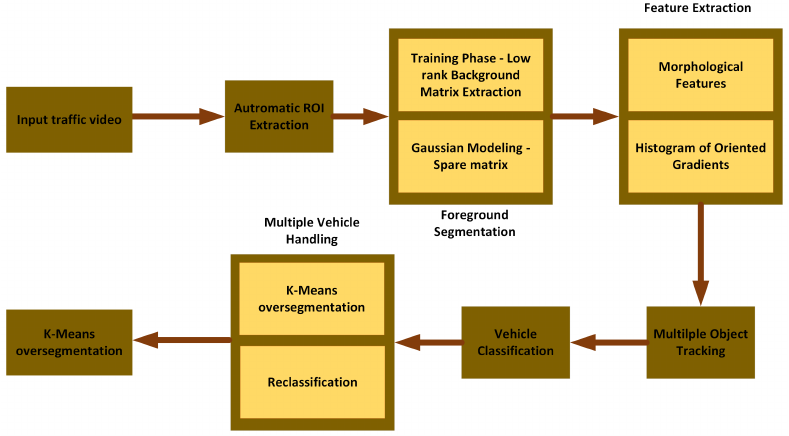
Figure 1. Proposed algorithm flow diagram.